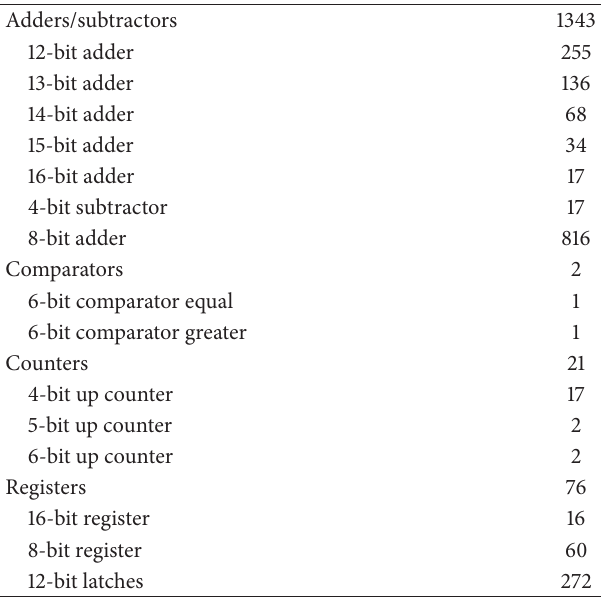
Table 3: Macrostatistics for VBSME